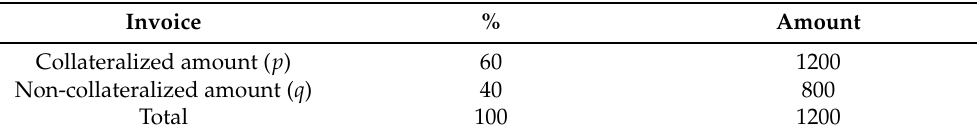
Table 3. Invoice